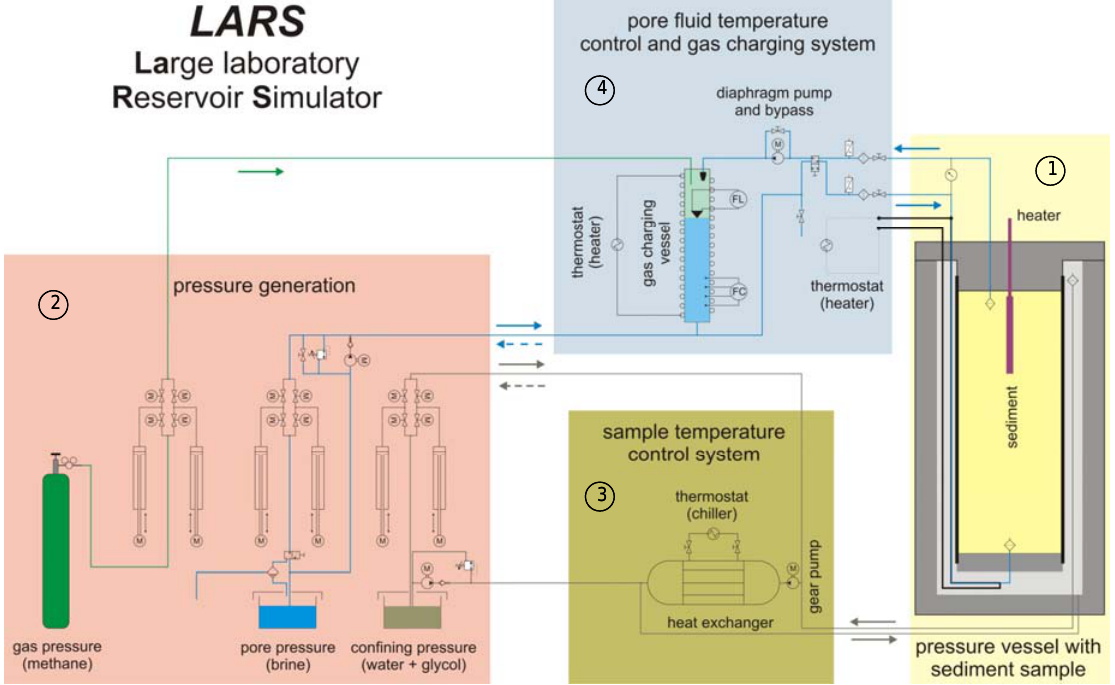
Figure 8. Technical sketch of the experimental set up “LARS”. The four components are described in detail in the